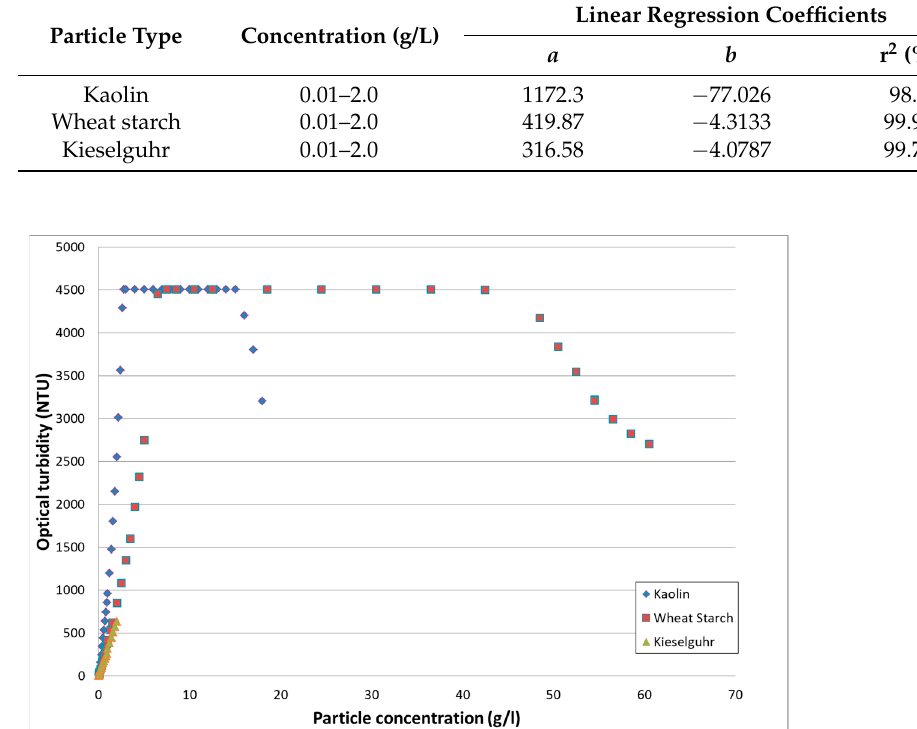
Figure 4. Evolution of the optical turbidity measured by a commercial turbidimeter as a function of the particle type and concentration.